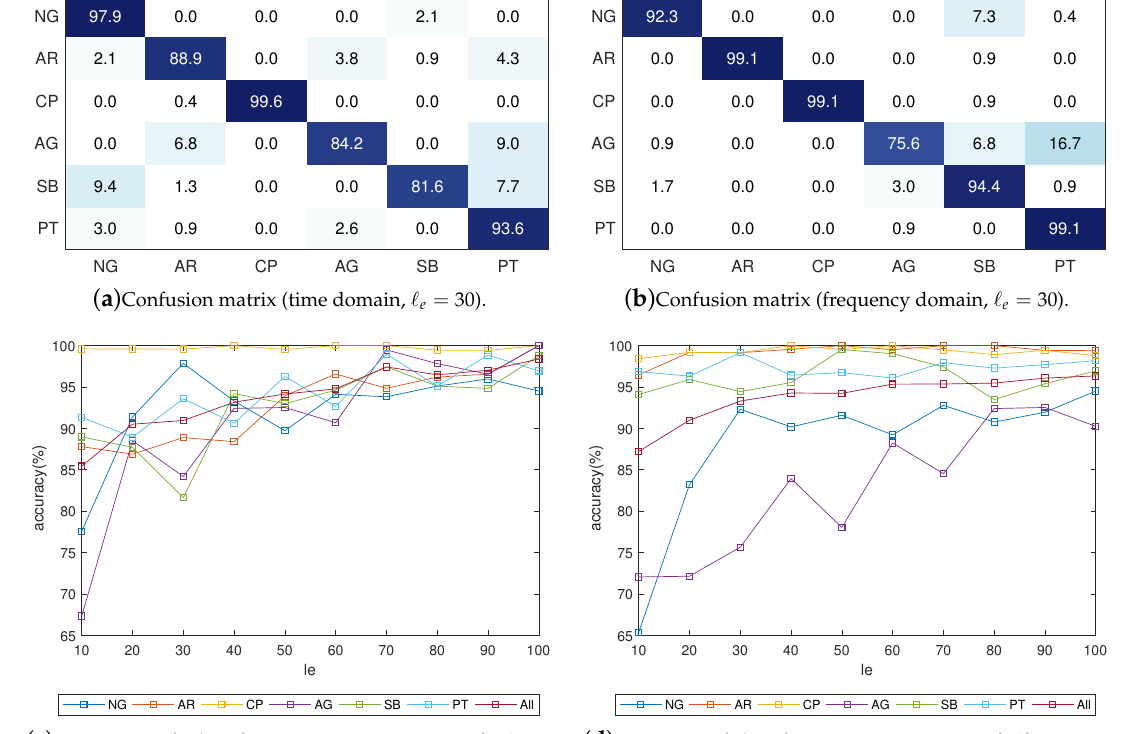
Figure 9. Classification performance of p-LapSVM under LS1 and dwelling time T d = 264 ( k 1 = 6,